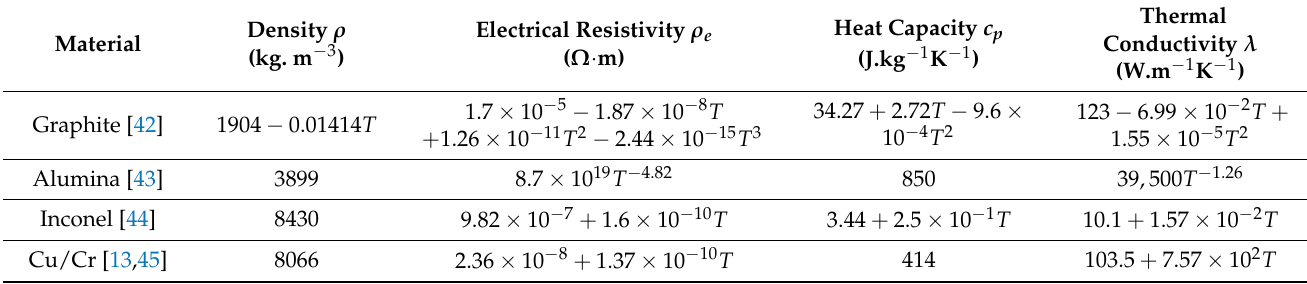
Table 1. Physical characteristics of different materials used for the